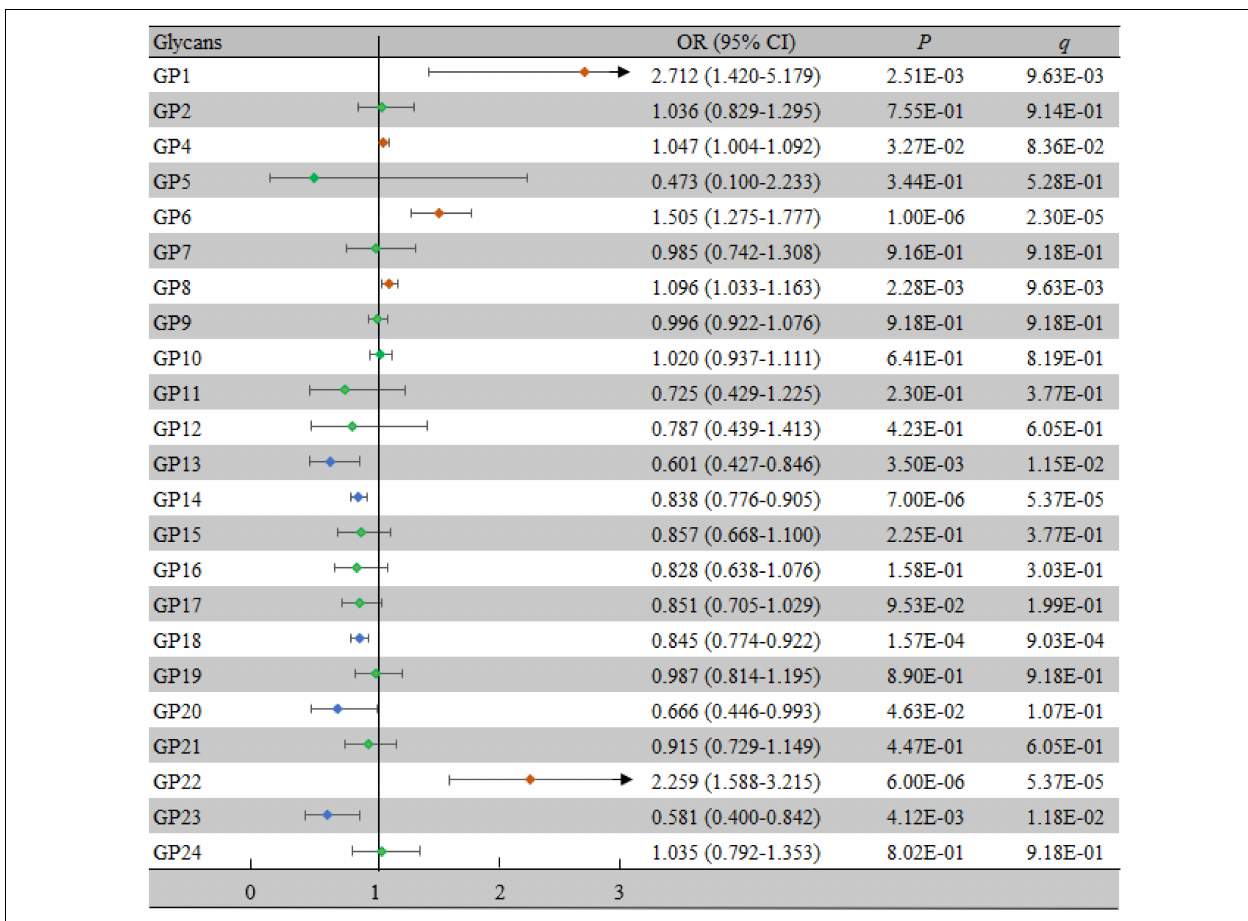
FIGURE 2 | Associations of the normalized initial glycans and VCI as determined by multivariate logistic regression analyses. P < 0.05 was considered statistically significant using logistic regression analysis; q < 0.05: significant after correction using FDR. The multivariate logistic regression analyses were performed after adjusting for age, BMI, education, income, smoking, drinking, salt intake habit, hypertension, hyperlipidemia, and diabetes mellitus. BMI, body mass index; CI, confidence interval; FDR, false discovery rate; GP, glycan peak; OR, odds ratio; VCI, vascular cognitive impairment.